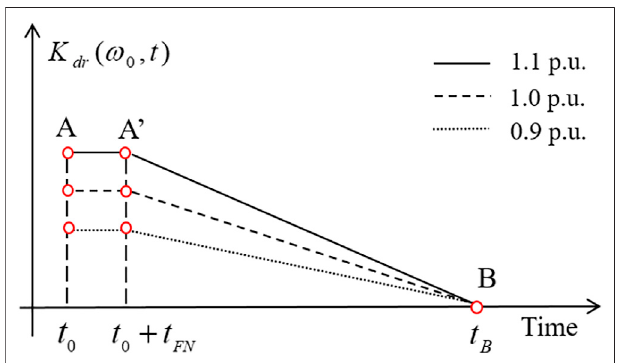
FIGURE 5 | Diagram of the proposed droop control gain in the time